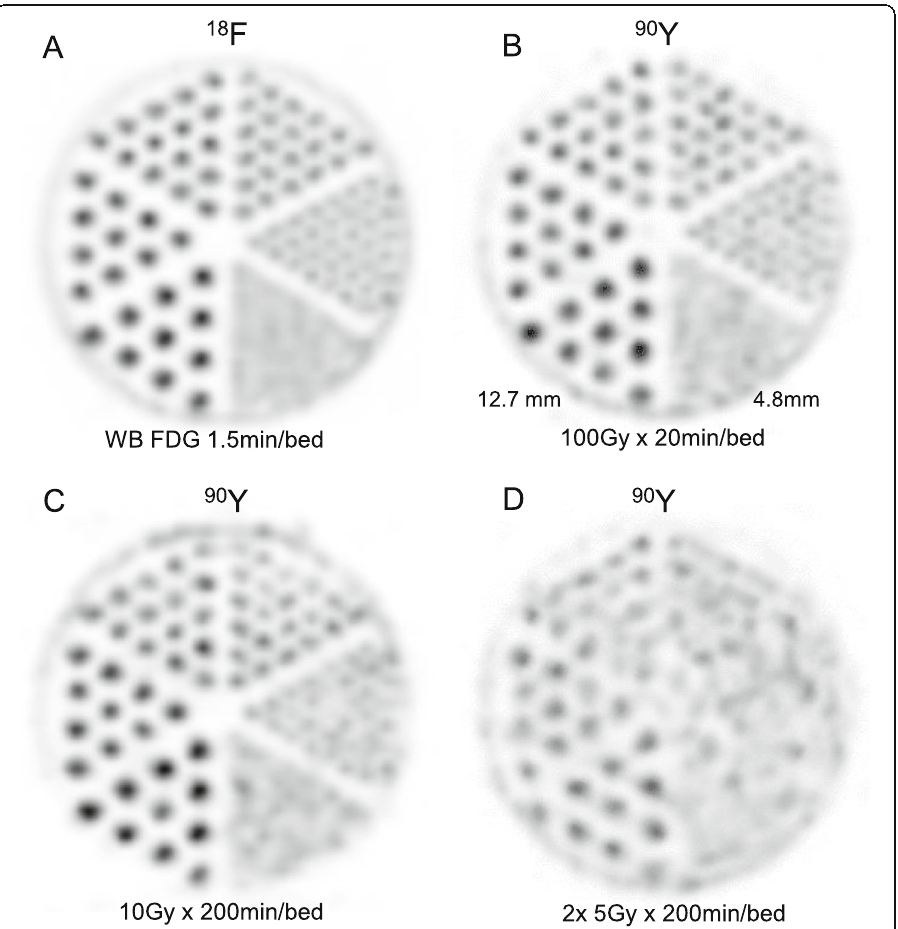
Fig. 2 a , b 18 F and 90 Y hot rod sector slices obtained using specific activities and acquisition times similar to that of clinical whole-body 18 F-FDG and of post 90 Y liver radioembolization, respectively. c , d 90 Y hot rod sector slices obtained using lower specific activities compensated by longer acquisition times, and additionally in d by slice summation, in order to get the same number of detected coincidences per